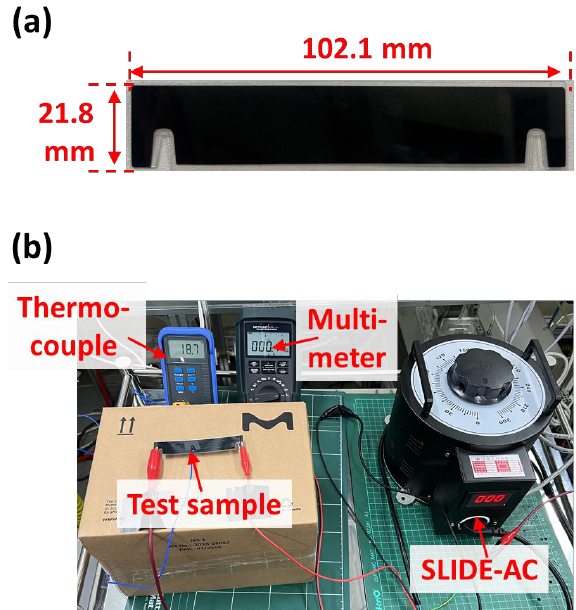
Figure 1. ( a ) Digital photo of the used carbon surface. ( b ) Experimental setup of the electrical resistance test for the characterization of electrothermal properties.